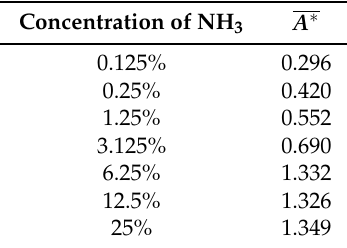
Table 5. Statistical comparison of the equilibrium absorption value reached for each ammonia concentration.